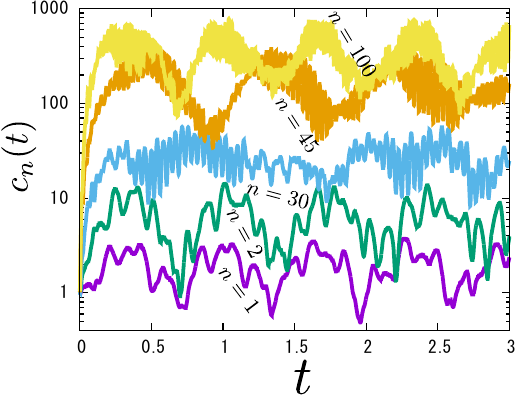
Figure 7 . Microcanonical OTOC for the stadium billiard with a/R = 1.